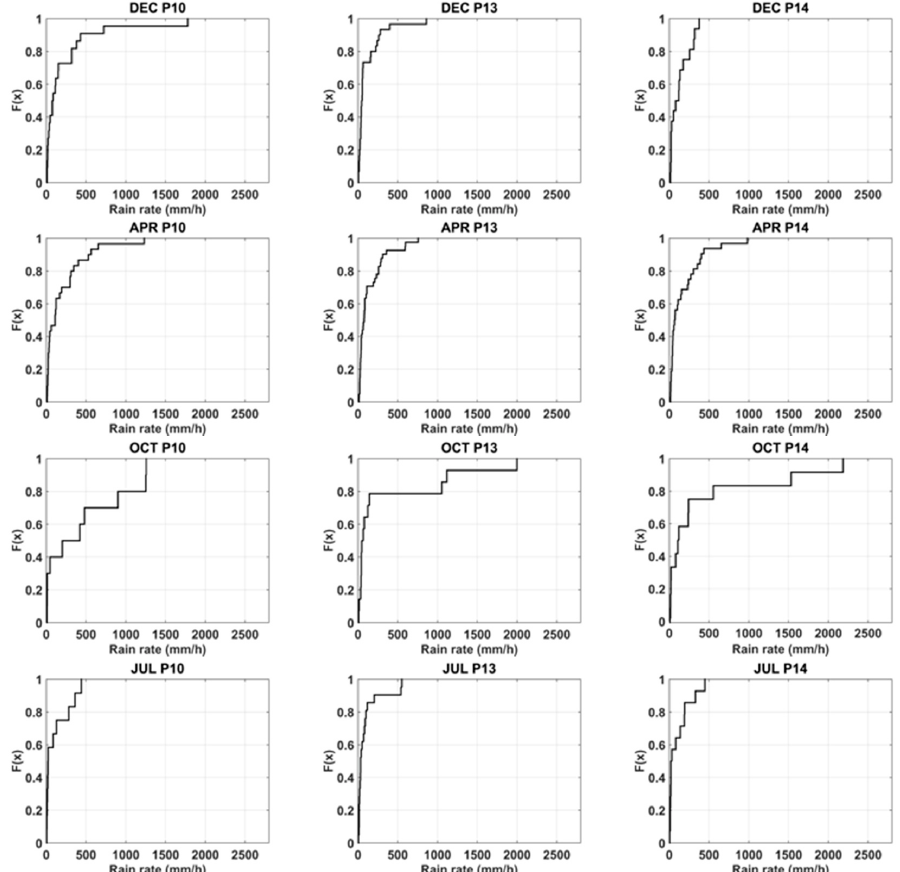
Figure 5. Cumulative distribution functions of 3B42RT pixels over Jeddah. P indicates the pixel numbers given in Figure 3. (Rain rates should be multiplied by 0.01).